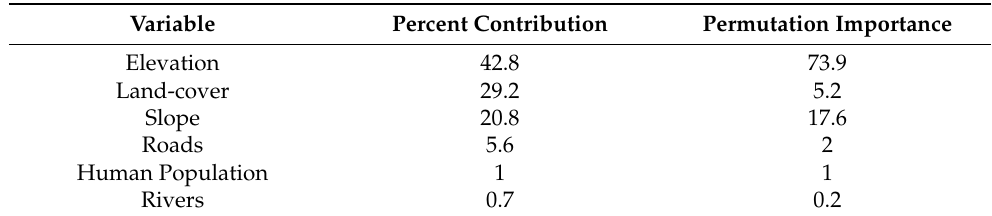
Table A2. The relative contributions of the environmental variables to the Maxent model in predicting prey distribution.